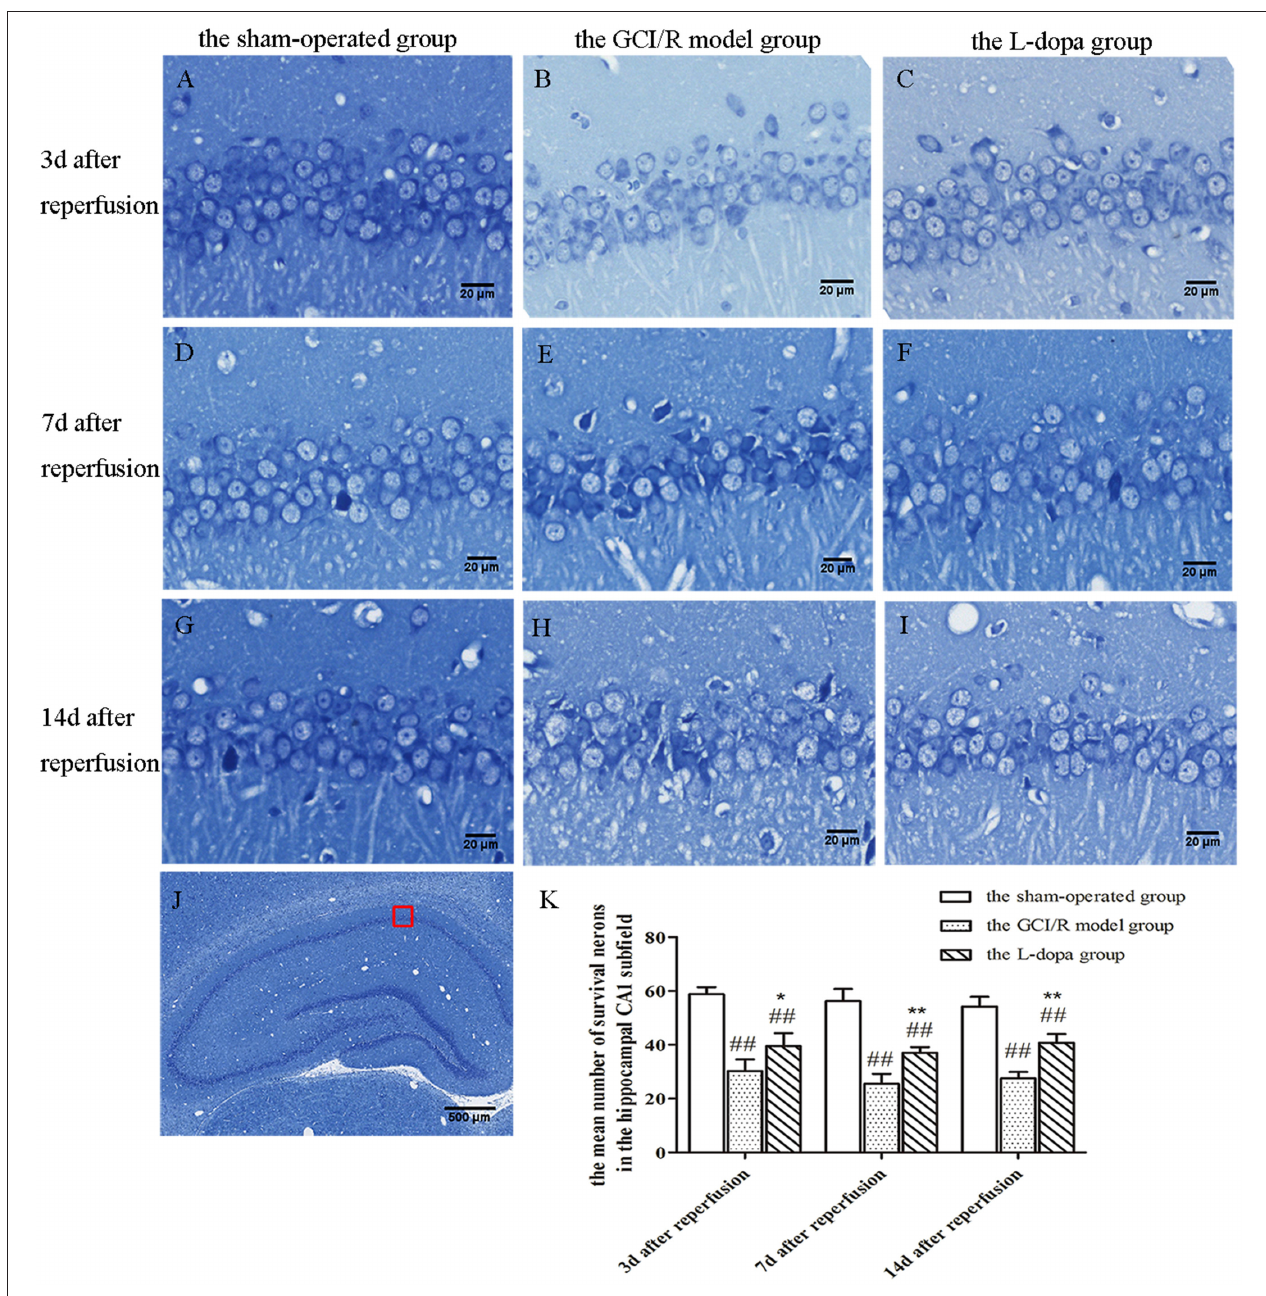
FIGURE 3 | Nissl staining of hippocampal CA1 subfield. (A–J) Representative section for Nissl staining at 3, 7, and 14 days after GCI/R injury. Scale bar 500 µ m for Magnification 4 × , Scale bar 20 µ m for Magnification 20 × . (K) The mean number of survival neurons in the hippocampal CA1 at 3, 7, and 14 days after GCI/R injury. Data are shown as means ± SD. ## p < 0.01 vs. the sham-operated group, ** p < 0.01 vs. the GCI/R model group. * p < 0.05 vs. the GCI/R model group.